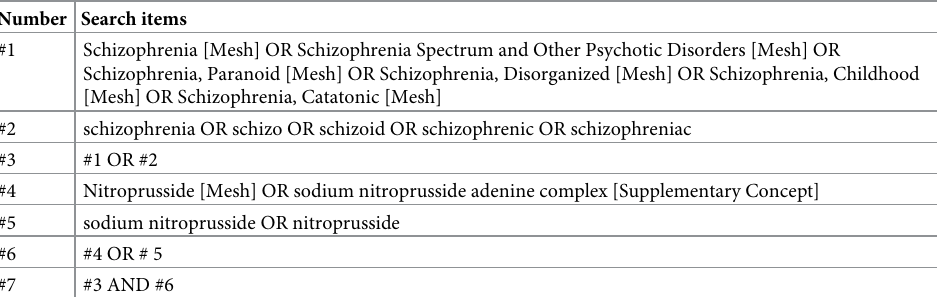
Table 1. Search strategy for PubMed.